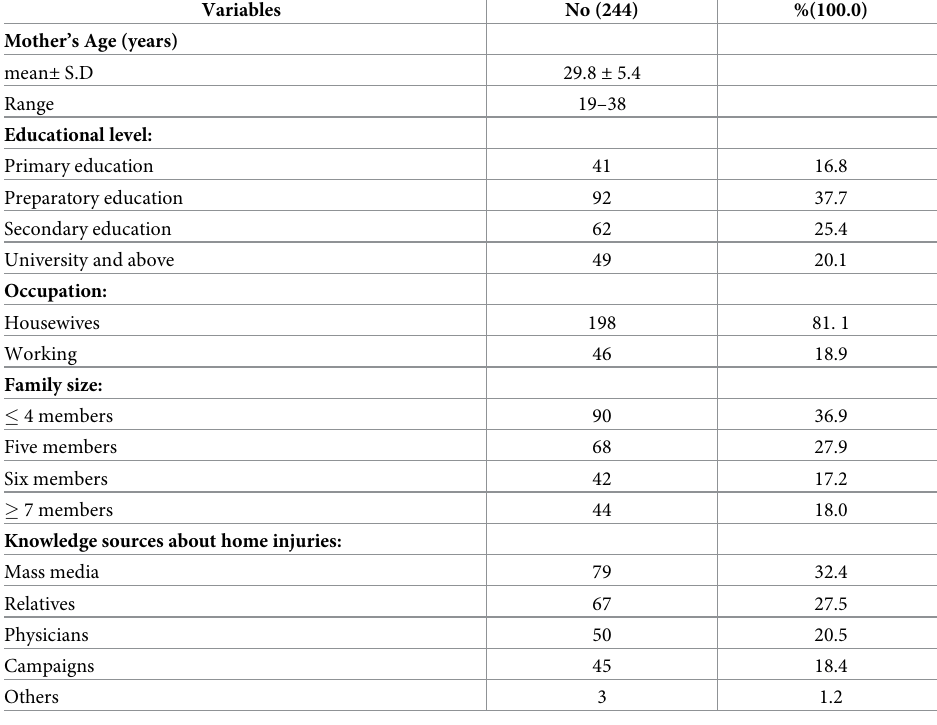
Table 1. General characters of the studied mothers. Variables No (244)